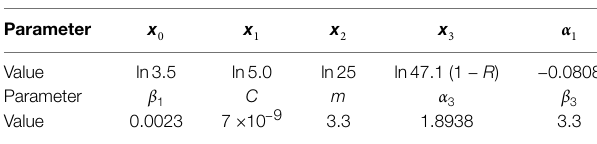
TABLE 3 | Parameters of the FCG